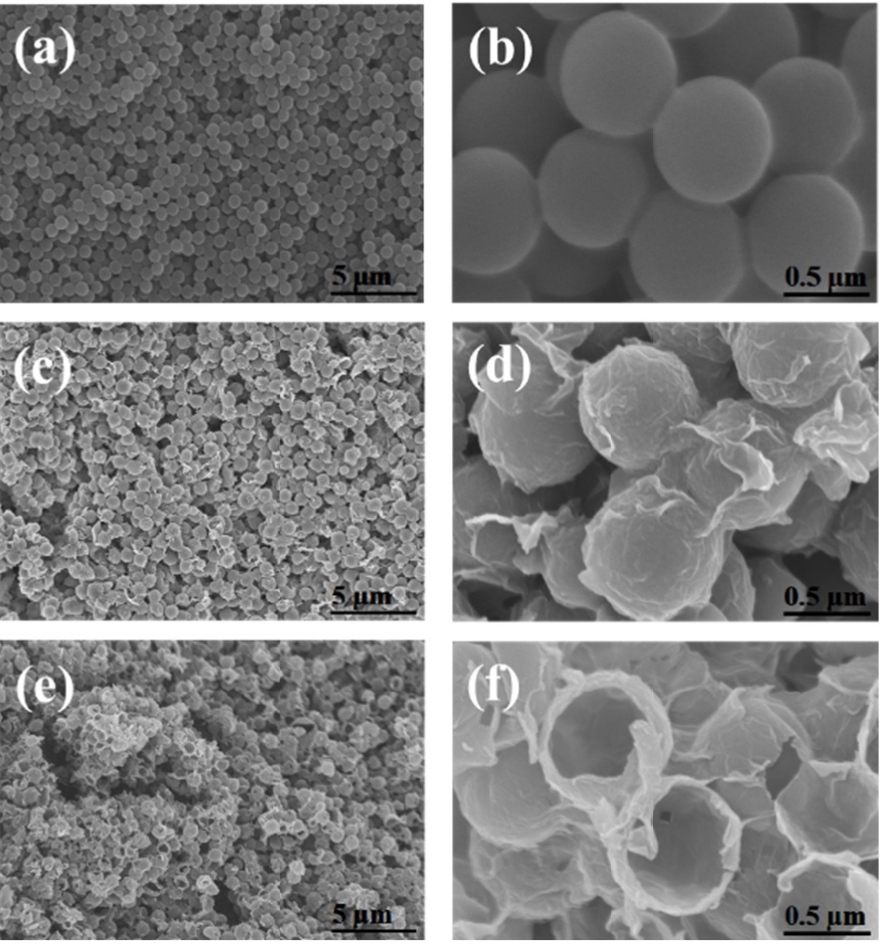
Figure 3. SEM images of the ( a , b ) PS beads, ( c , d ) PS/GO core–shell, and ( e , f ) MRGO-HS. The morphological features of MRGO-HS are also shown in the HRTEM